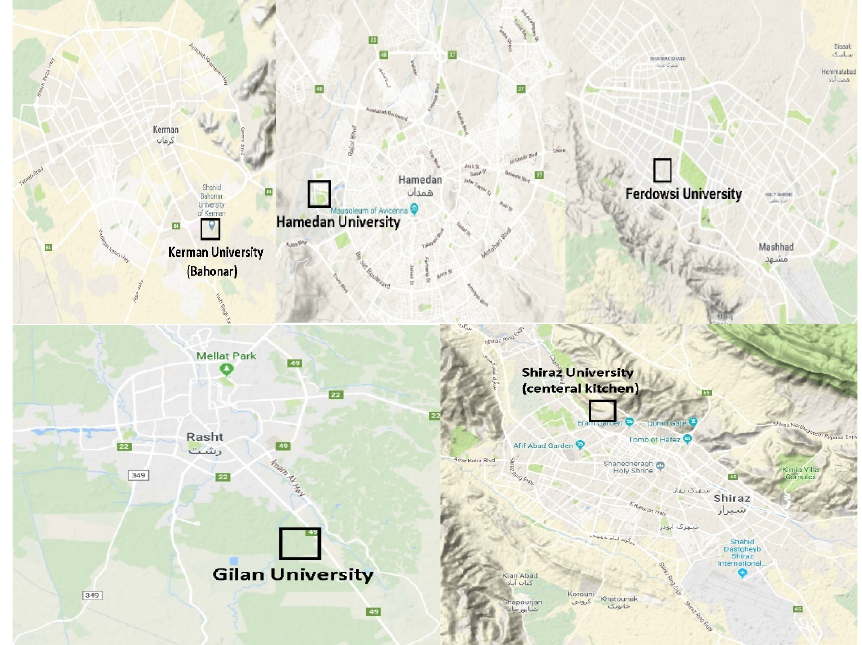
Fig. 1. Map of source sampling